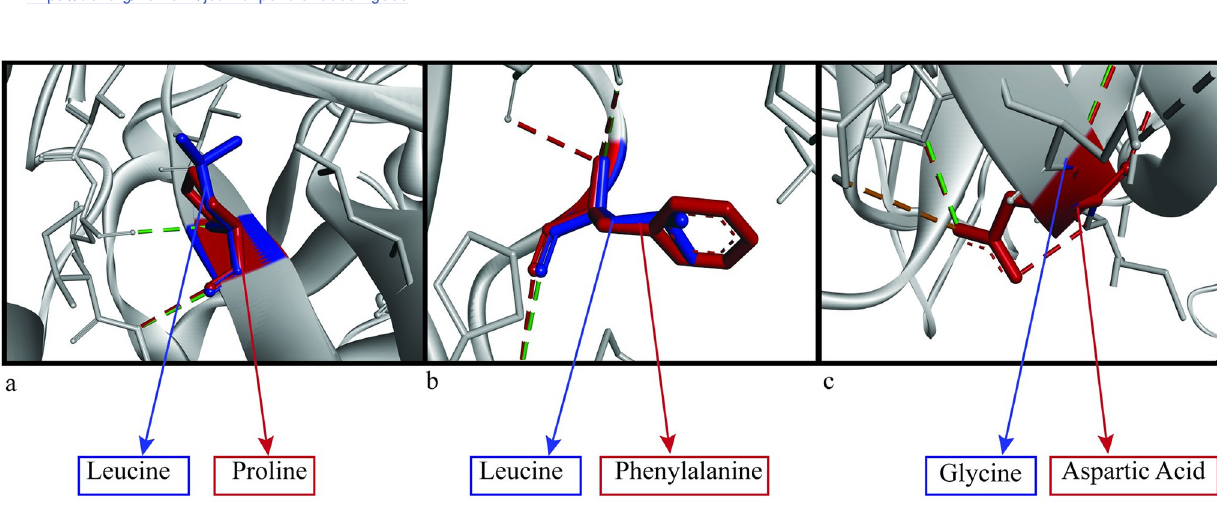
Fig 7. Superimposed protein structures of native and mutant structures (a) L411P, (b) L455F and (c) G493D showing comparison of hydrogen bonds. Blue color shows native residues, Green color shows hydrogen bonds of native residues and Red color shows mutant residues and their hydrogen bonds.